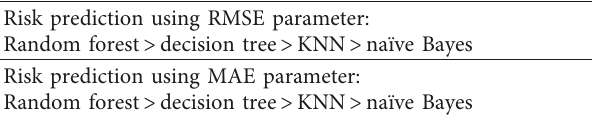
Table 2: Comparison of order of all the techniques used.